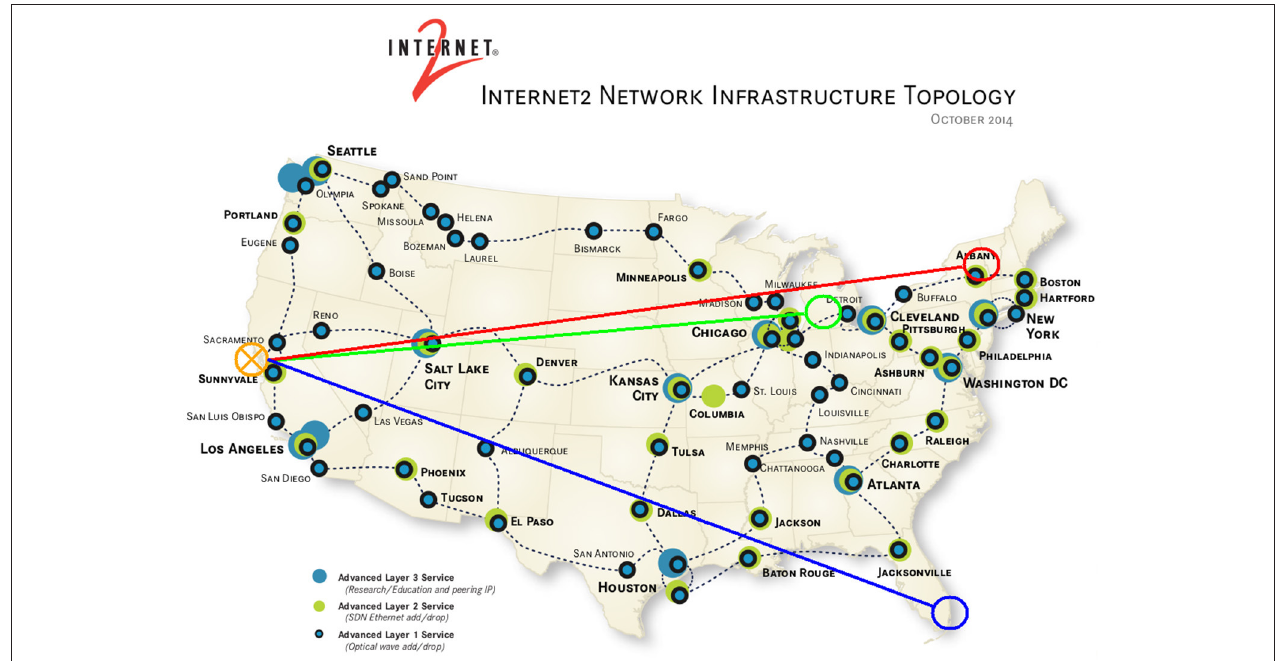
FIGURE 4 | NPAPW 2016 demonstration of WAIR system. The red, green and blue lines indicate individual freeverb “rooms” which are cross-patched at the summing site in California. Musicians in New York, Michigan and Florida could hear each other in a conjoined acoustical